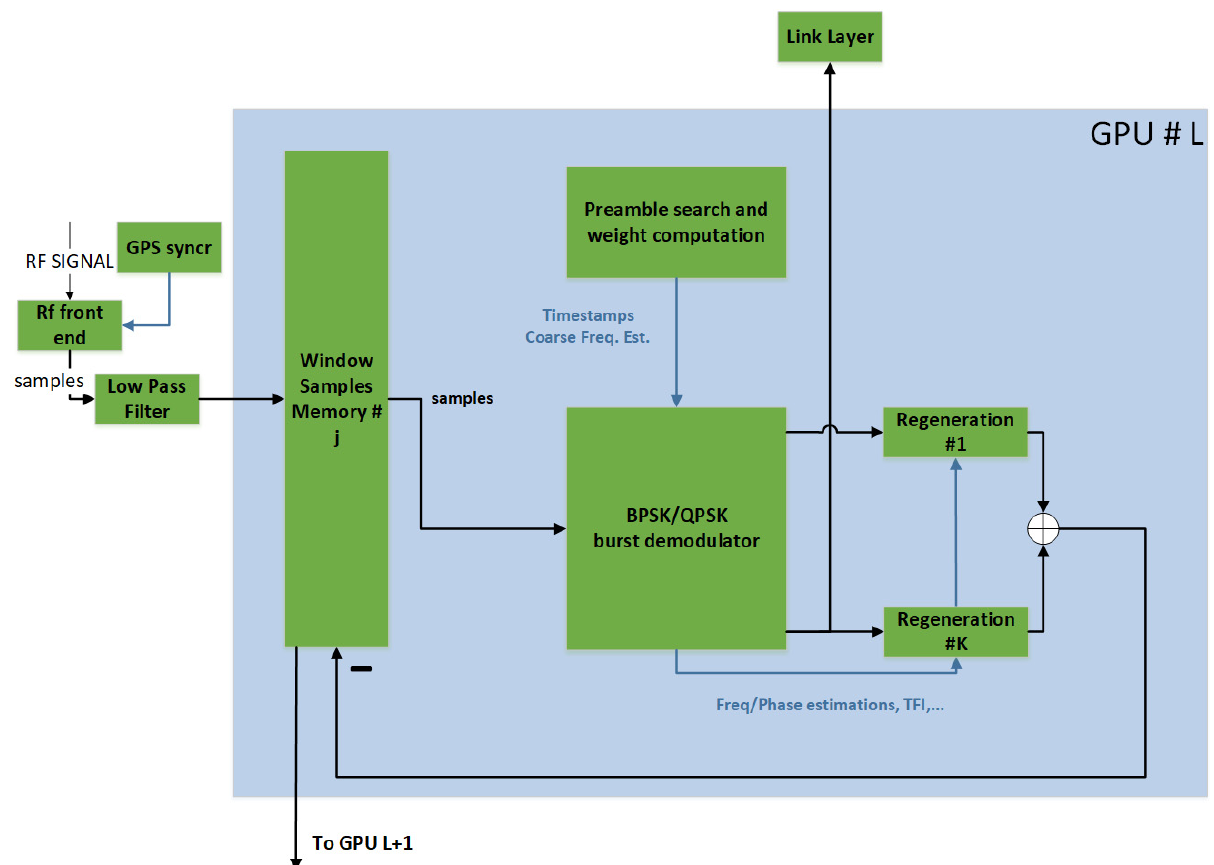
Figure 4. ME-SSA receiver block scheme executed on the generic L th GPU (i.e., GPU #L).